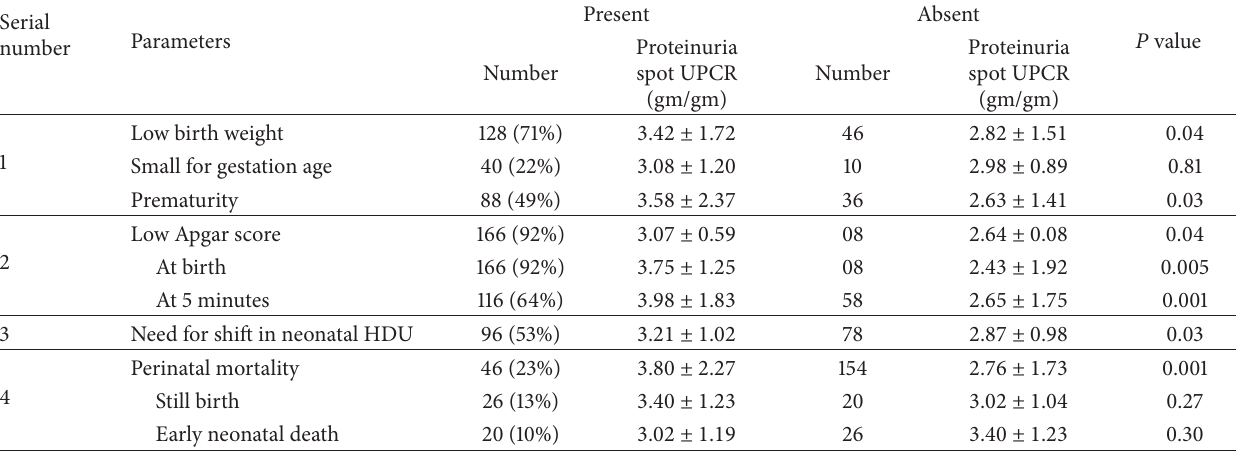
Table 4: Fetal complications and outcome and spot UPCR in the patients of